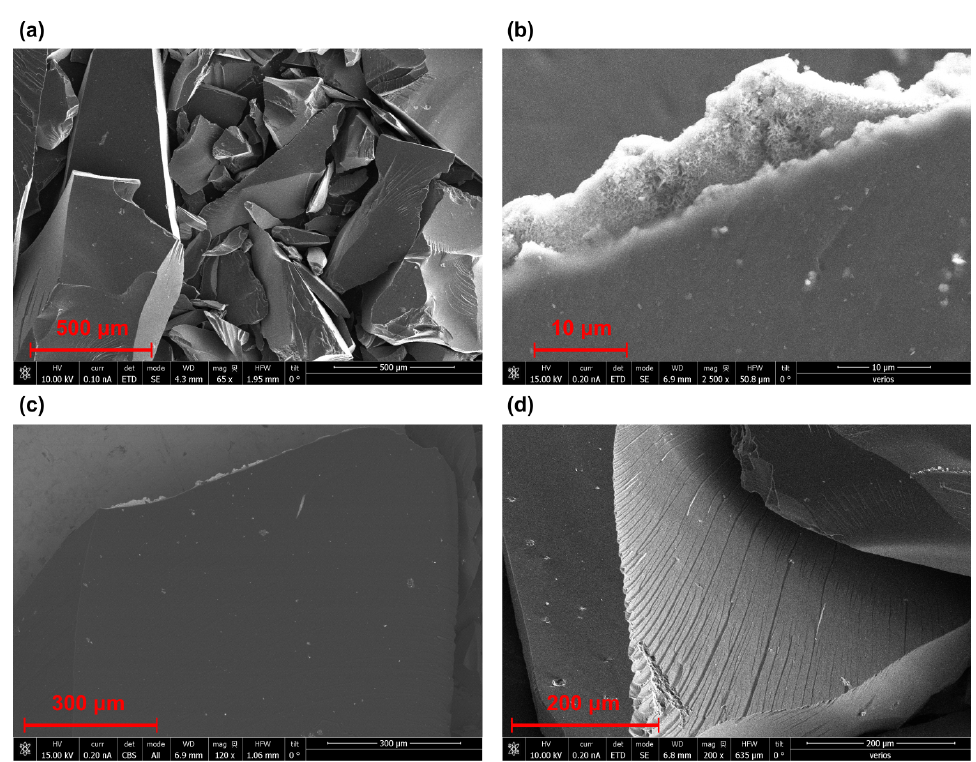
Figure 2. Scanning electron microscopy images of shungite particles: ( a ) general view of particles at a magnification of × 65, ( b ) shungite surfaces with chemical inclusions at a magnification of × 2500, ( c ) shungite surfaces with chemical inclusions at a magnification of × 120 and ( d ) shungite surface with characteristic chips particles at a magnification of ×